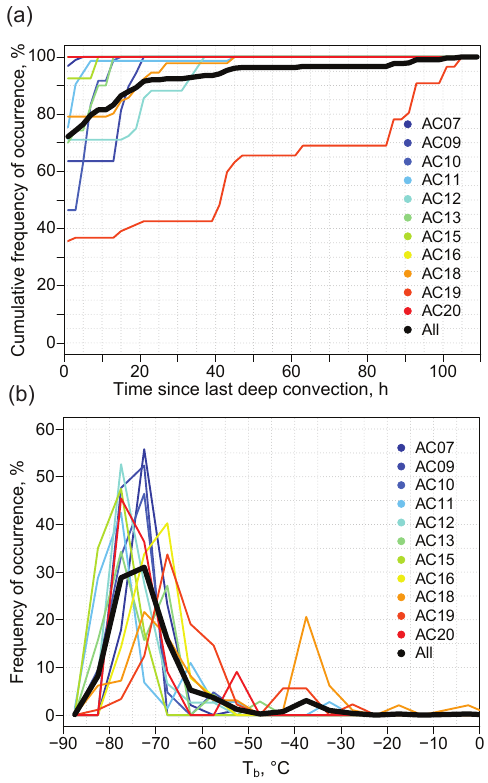
tion for flight segments with elevated aerosol concentrations (cumu- lative frequency, all flights); (b) frequency distribution of minimum GOES brightness temperature ( T b ) for selected flights legs (within 5-day backward